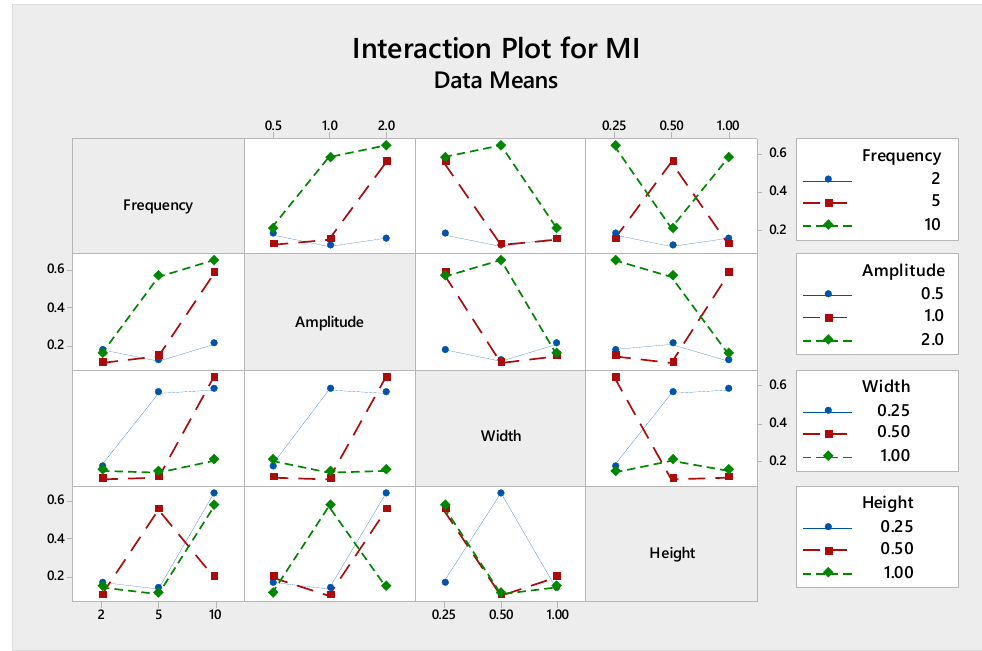
Figure 4. The interactions of various parameters with respect to mixing index.